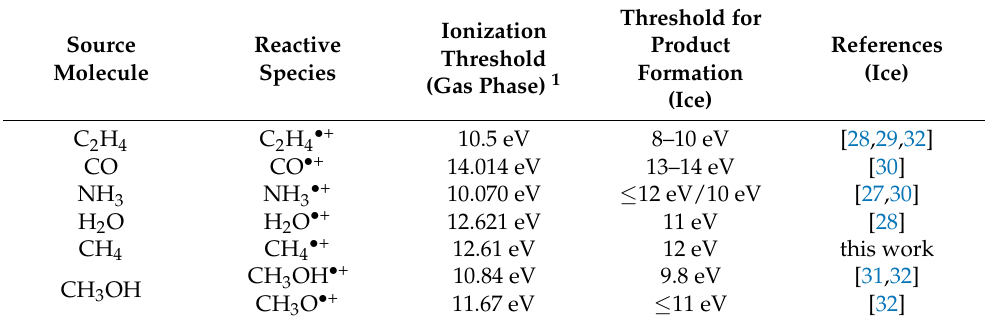
Table 2. Reactive species formed by EI and DI as relevant to the electron-induced reactions in molecular ices discussed in Section 4. Note that the listed species were not directly detected but their contribution to the reactions is deduced indirectly from the identified final reaction products. Other electron-molecule interactions may contribute as well as summarized in Sections 3.3 and